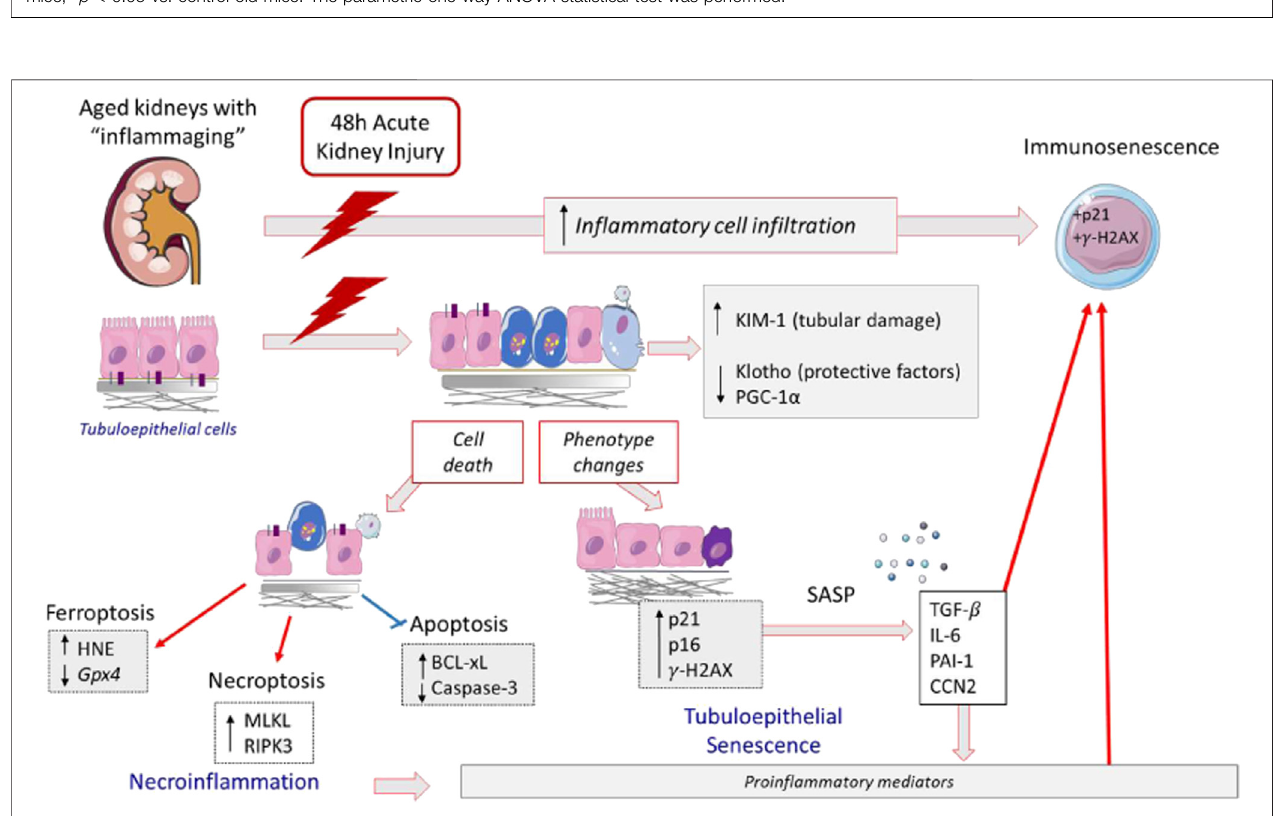
FIGURE10| Proposedmechanismsinvolvedinaging-relatedFA-AKIincreasedsusceptibility.InresponsetoFAinjury,agingkidneyspresentanincreaseofKIM-1 expression, indicator of tubular damage, lower levels of nephroprotective factors and immunosenescent in fi ltrating cells. The tubular cell damage can be lethal; in FA- agingkidneysthereisanactivationofin fl ammatoryformsofcelldeath,suchasnecroptosisandferroptosis,aswellasaninhibitionofapoptosis.Inagingkidneys,injured tubular cells change their phenotype to a proin fl ammatory and senescent one, being IL-6 one of the most upregulated cytokines. These cellular and molecular changes may partially underlie the age-related increased susceptibility to developing more severe AKI in response to FA.